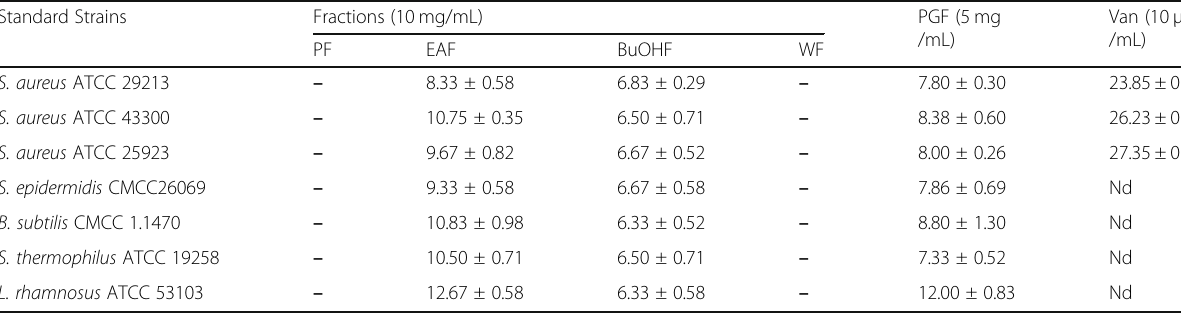
Table 1 IZDs (mm) of different fractions of PCP extracts Standard Strains